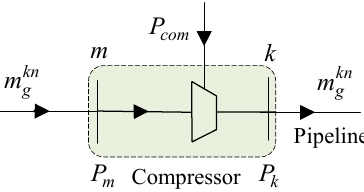
Figure 3. The electric compressor model of the gas pipe.